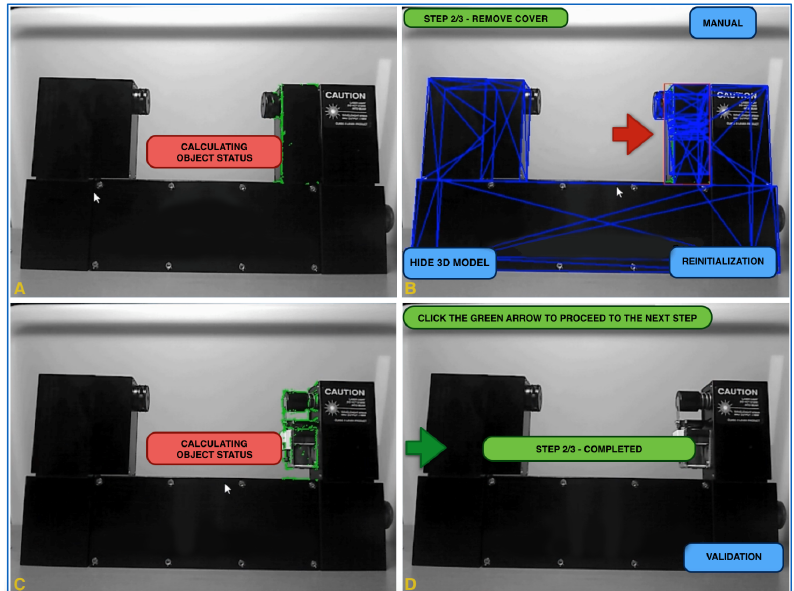
Figure 15. Industrial laser calibrator’s external cover removal. The object status is calculated ( A ), the instruction are provided to the user ( B ), the system computes the object status again ( C ) and finally the step is evaluated as completed ( D